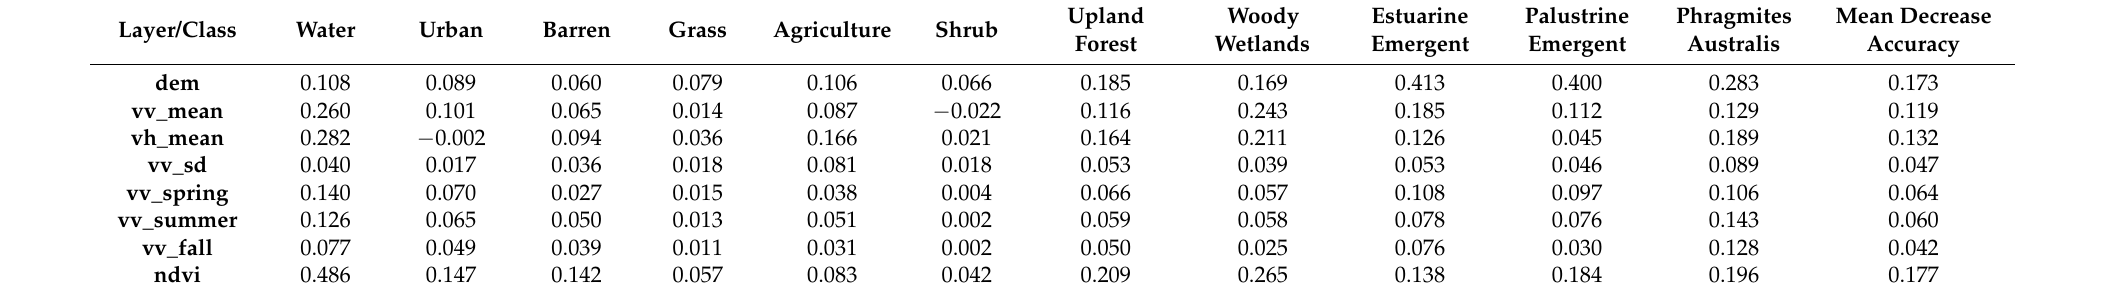
Table 5. Gulf Coast level-1 random forest classification importance